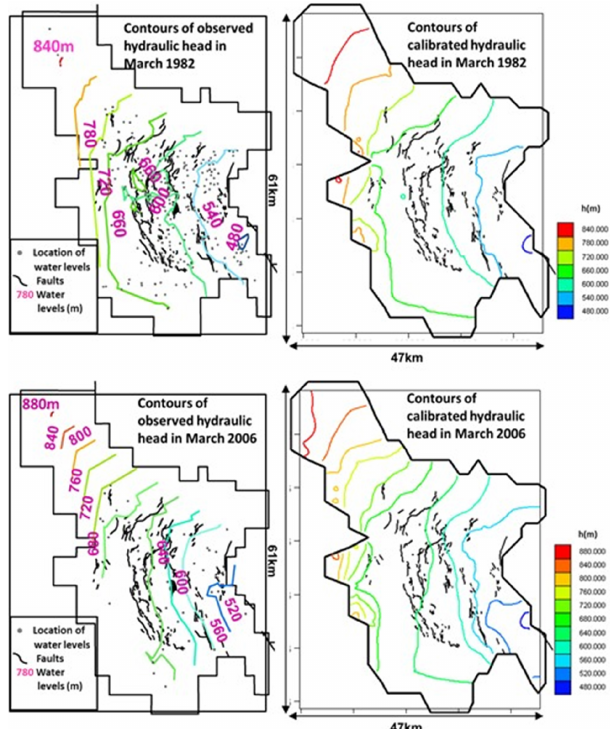
Figure 4. Observed (left) vs simulated (right) water levels after 1982 (top) and 2006